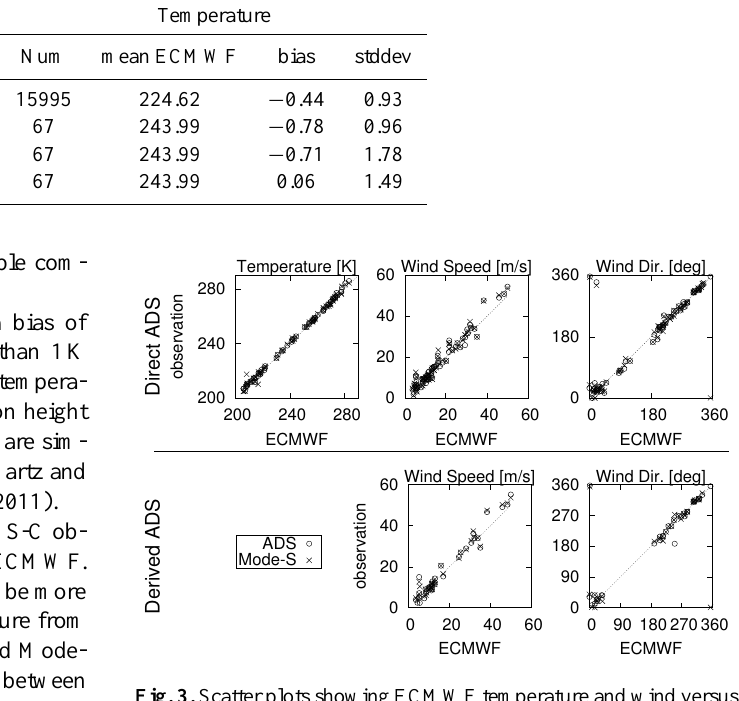
Fig. 3. Scatter plots showing ECMWF temperature and wind versus ADS-C (direct and derived) and